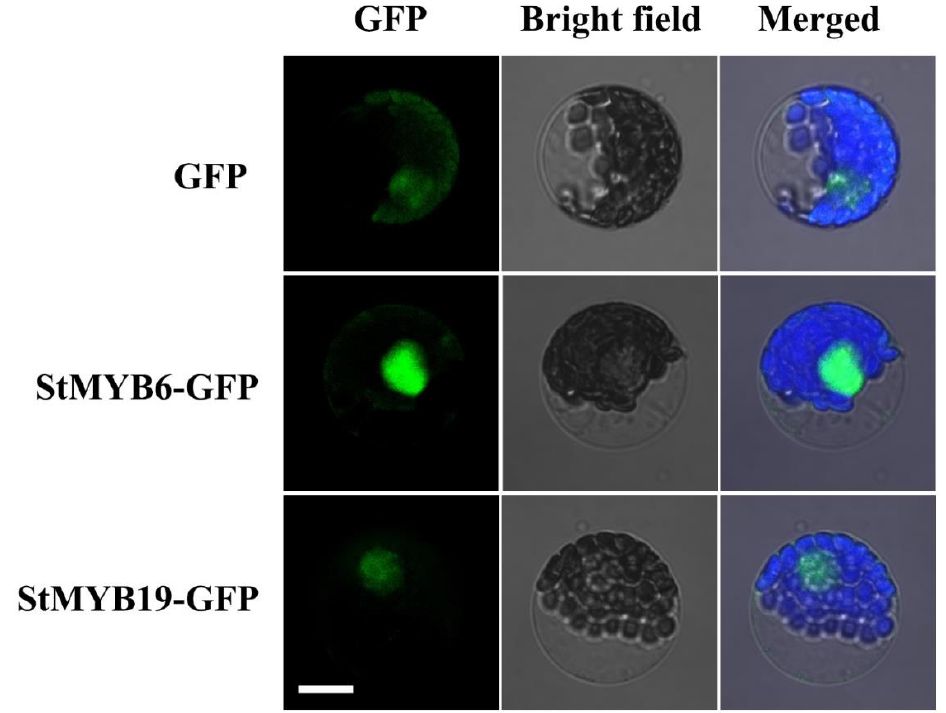
Figure 9. Subcellular localization of StMYB6 and StMYB19 in Arabidopsis thaliana (L.) Heynh. protoplasts. Enhanced green fluorescent protein (eGFP), StMYB6-eGFP, and StMYB19-eGFP under the control of the CaMV35S promoter separately transiently expressed in Arabidopsis thaliana (L.) Heynh. protoplasts. eGFP fluorescence signal was observed by Olympus confocal microscope. Scale bars = 10 µm.